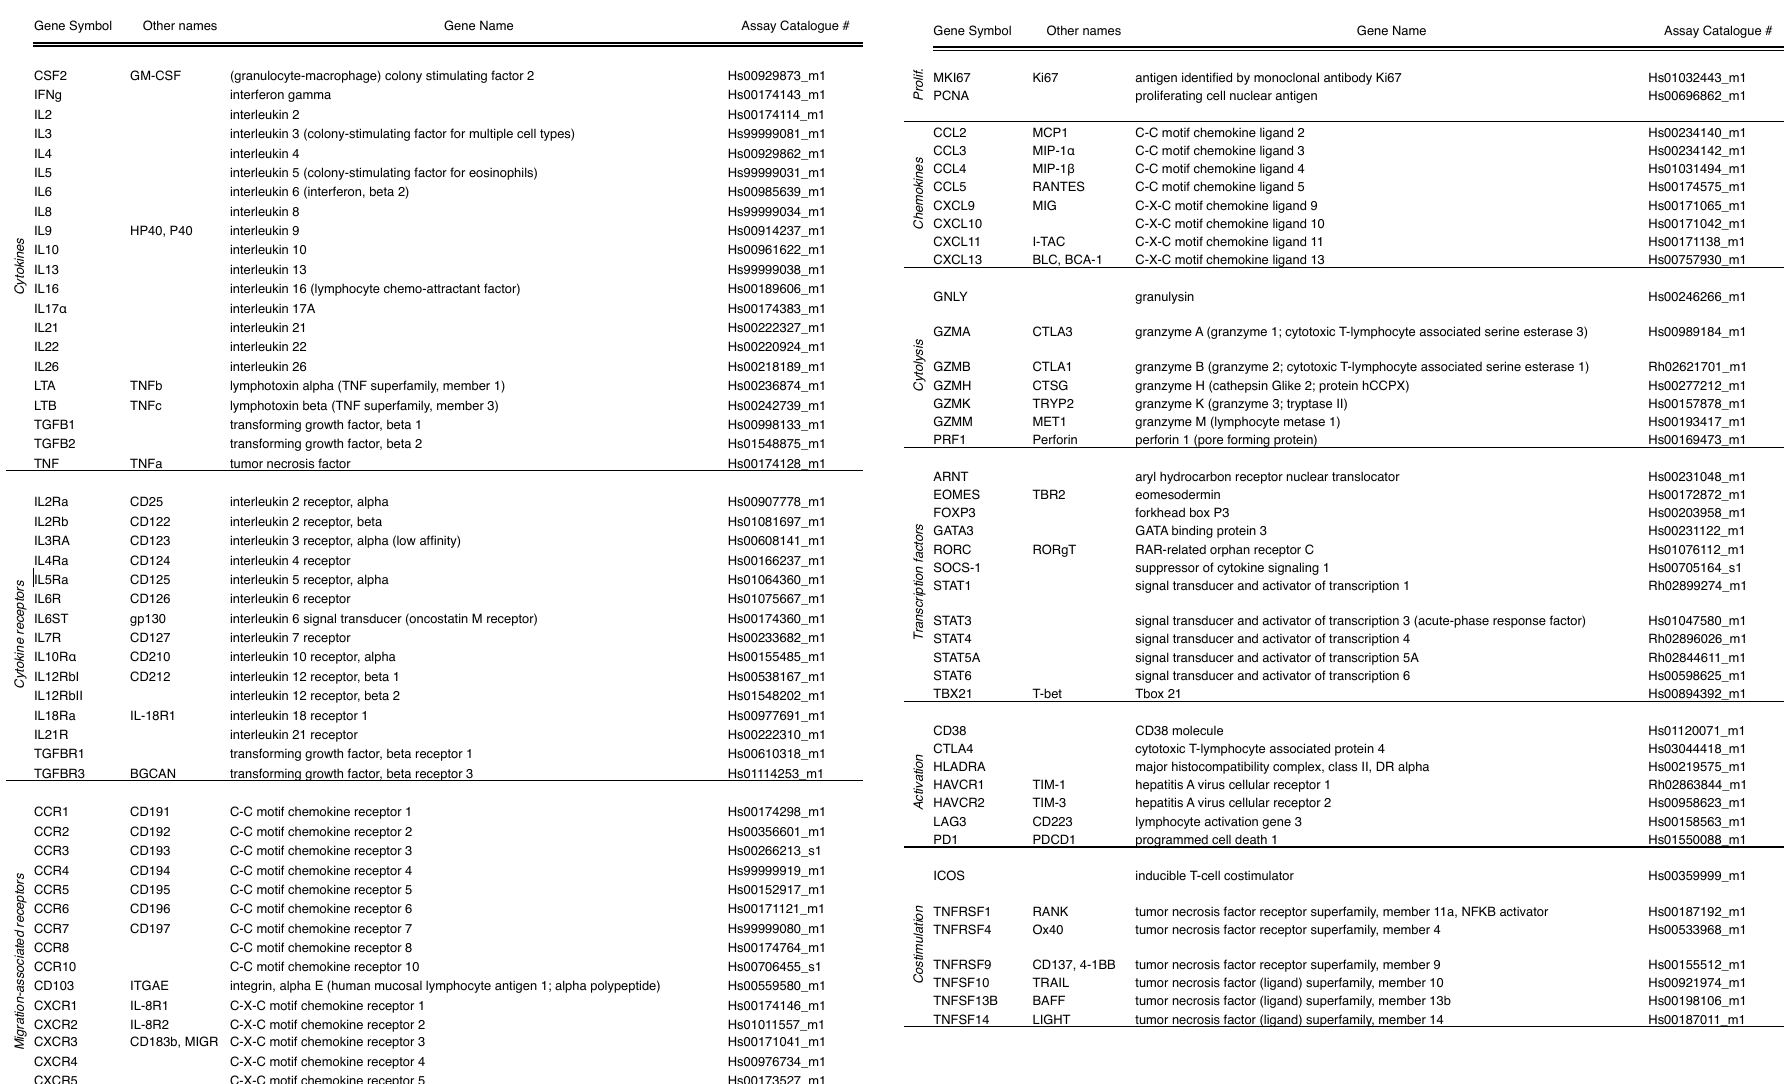
Supplementary Table 2. Genes investigated by quantitative RT-PCR